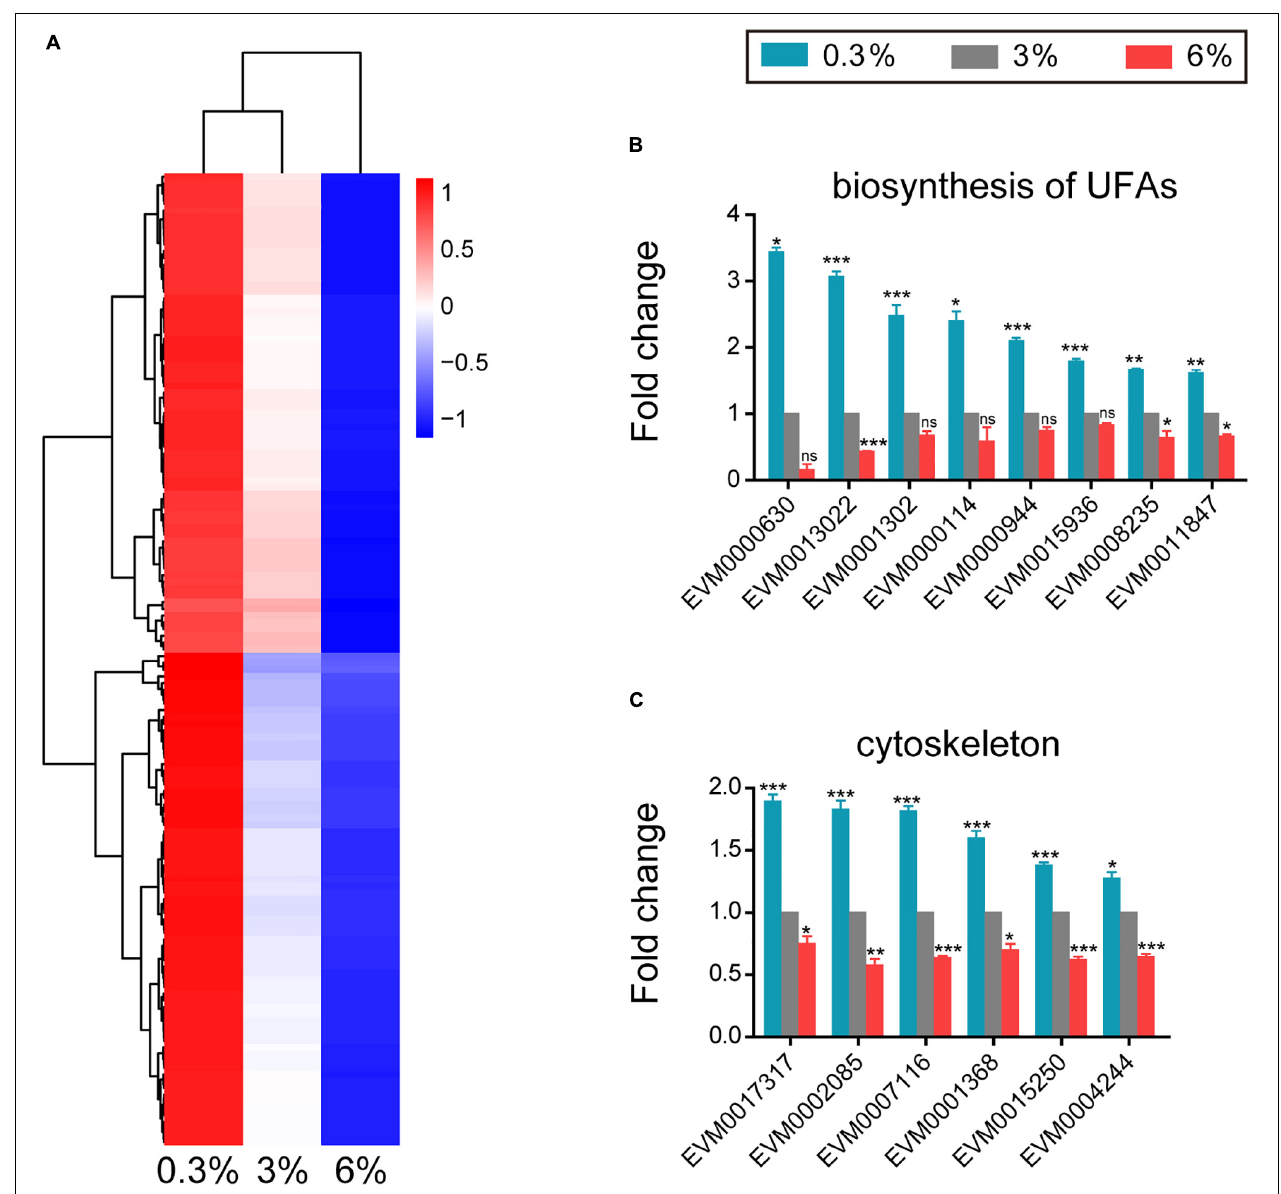
FIGURE 4 | Genes that up-regulated in expression with decreasing salinity. (A) Hierarchical clustering of 144 DEGs that up-regulated in expression with decreasing salinity, performed using the pheatmap package in R. | log2foldchange| > 0; DESeq2 padj < 0.05 was set as the differential gene screening threshold. Relative expression levels (z-score, log-transformed gene expression level based on FPKM value) were indicated for each gene (row) in each sample (column). Red indicates upregulation; blue indicates downregulation. The scale bar shows the z-score for a differentially expressed gene. (B) Expression level of genes involved in biosynthesis of unsaturated fatty acids (UFAs). (C) Expression level of cytoskeleton tubulin and related intraflagellar transport (IFT) genes. Fold change indicates the ratio of FPKM value of the treatment group (0.3%, 6%, as indicated) to that of the control group (3%). The error bars represent standard error of the mean of three biological replicates per condition. The comparisons between the treatment and control groups were analyzed statistically using the Benjamini and Hochberg’s methods calculated by DESeq2. The value of padj < 0.05 was considered statistically significant. *padj < 0.05, **padj < 0.01, ***padj < 0.001, ns–not